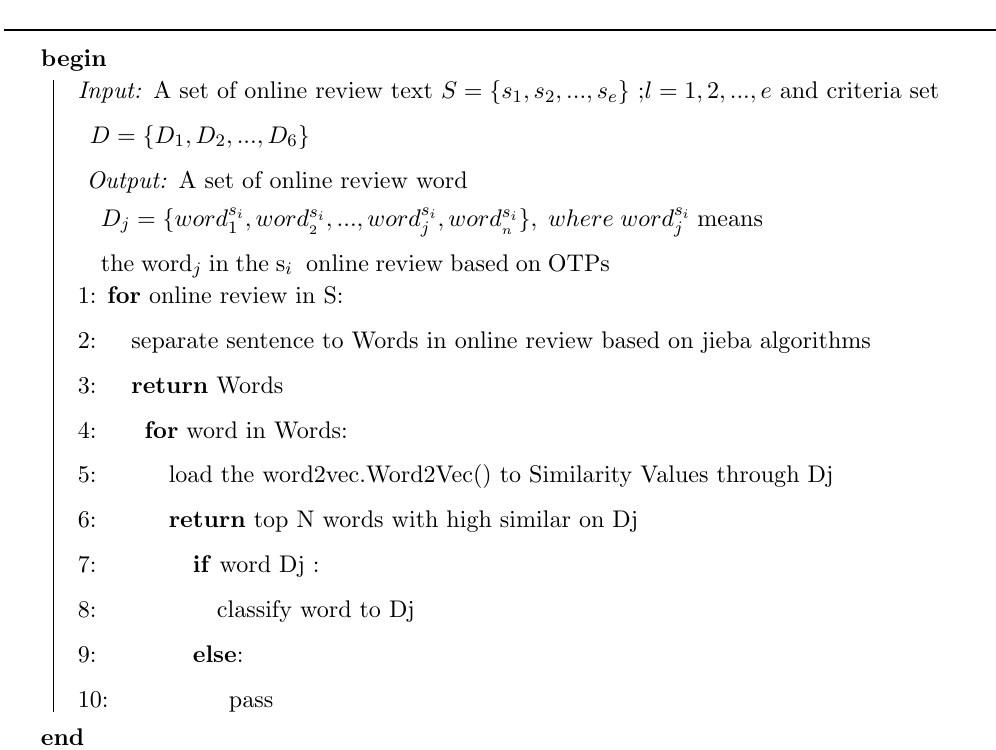
Algorithm 2: Extracting and clustering textual information based on Word2Vec algorithms